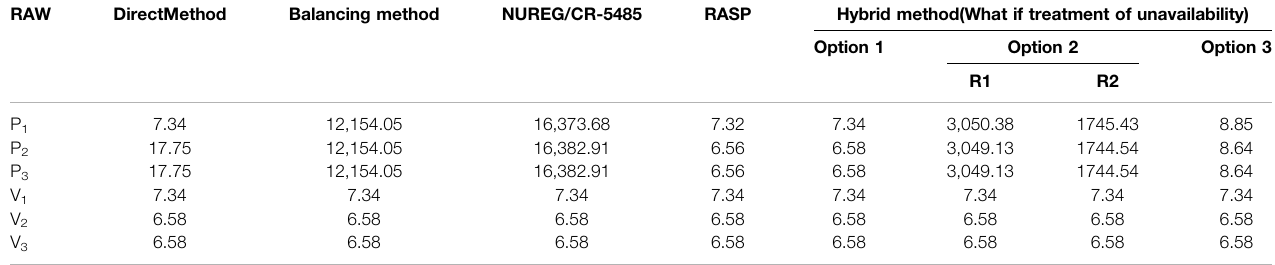
TABLE 3B | RAW importance results of different methods (t (cid:2) 360 h). RAW DirectMethod